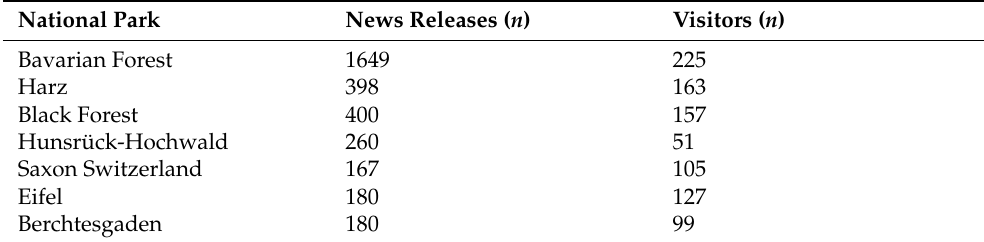
Table A1. German forest-dominated national parks with bark beetle disturbances, the number of respondents who reported visiting those parks ( n = 927), and the number of press releases mentioning bark beetle infestations ( n = 2878).